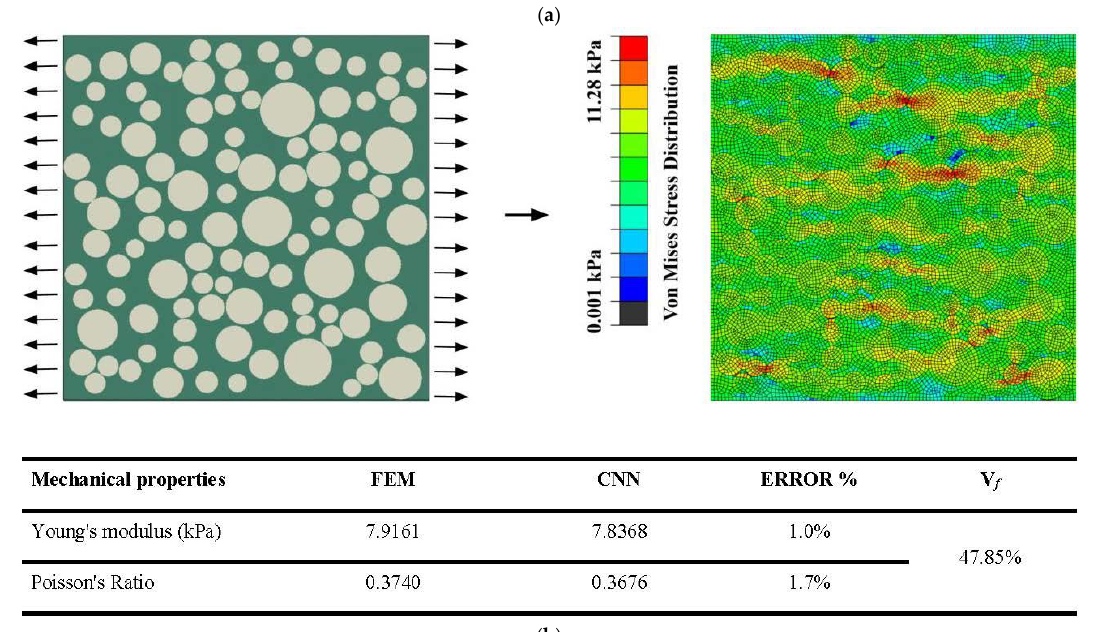
Figure 5. The prediction error of Young ’ s modulus and Poisson ’ s ratio for two representative cases with V f at ( a ) 27.73% and ( b ) 47.85%.